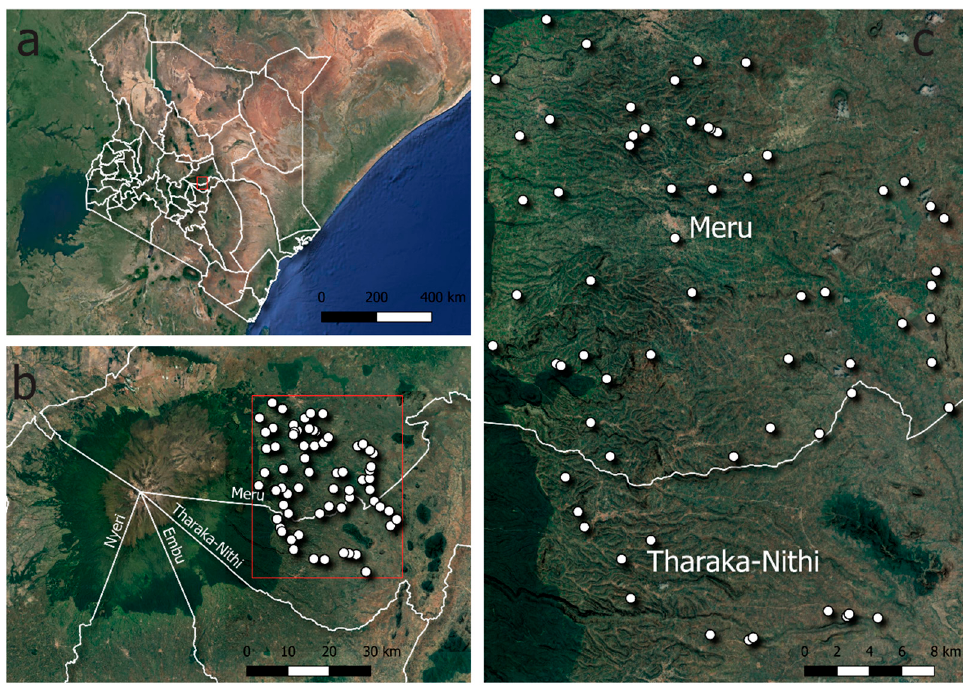
Figure 1. Map of Kenya showing the location of the study area ( a ), distribution of sampling sites within the study area ( b ), the spatial distribution of sampling points ( c